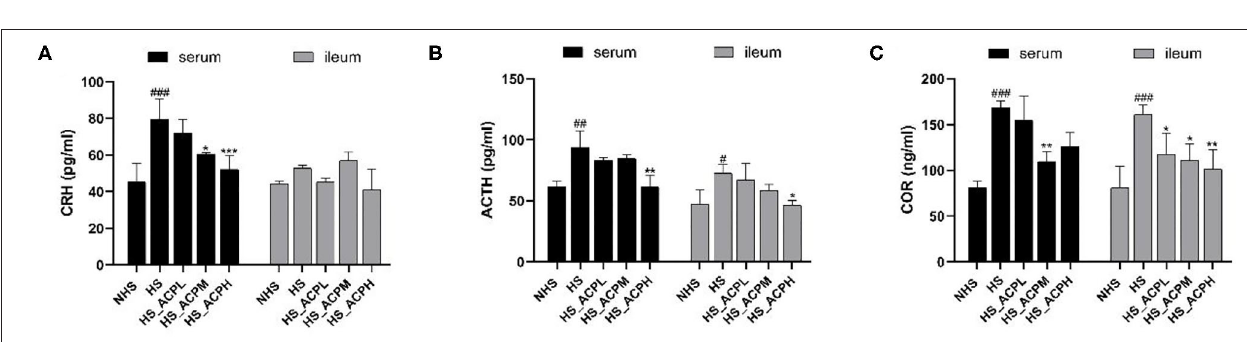
FIGURE 3 | Effects of ACP supplementation on the levels of hypothalamus-pituitary-adrenal (HPA) axis in the serum and ileum. (A) corticotropin releasing hormone (CRH), (B) adrenocorticotropic hormone (ACTH), (C) corticosterone (COR). Data are presented as the mean ± SEM. # p < 0.05, ## p < 0.01, ### p < 0.001 compared with the NHS group; * p < 0.05, ** p < 0.01, *** p < 0.001 compared with the HS